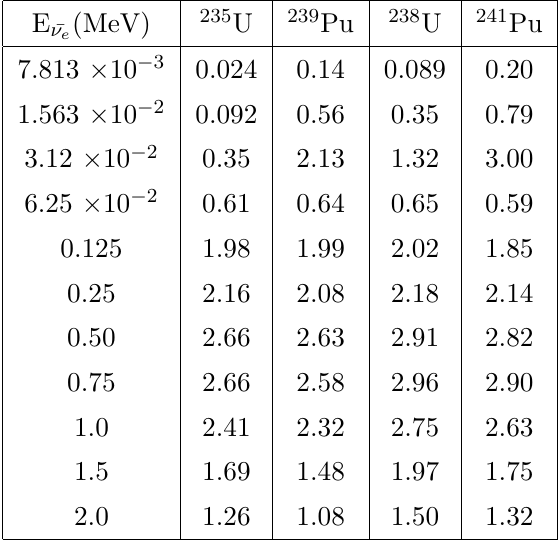
Table 1 . Tabulated values of the antineutrino spectrum of each (cid:12)ssile isotope in units of (cid:22) (cid:23) e /MeV/(cid:12)s.